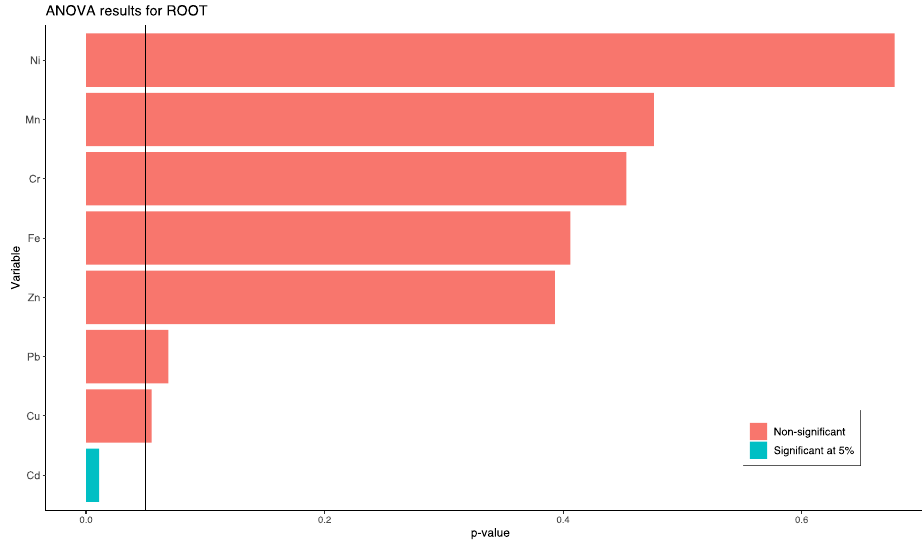
Agronomy 2021 , 11 , x FOR PEER REVIEW Figure 6. Dendrogram of 31 allotment plots calculated on the basis of root parameters.